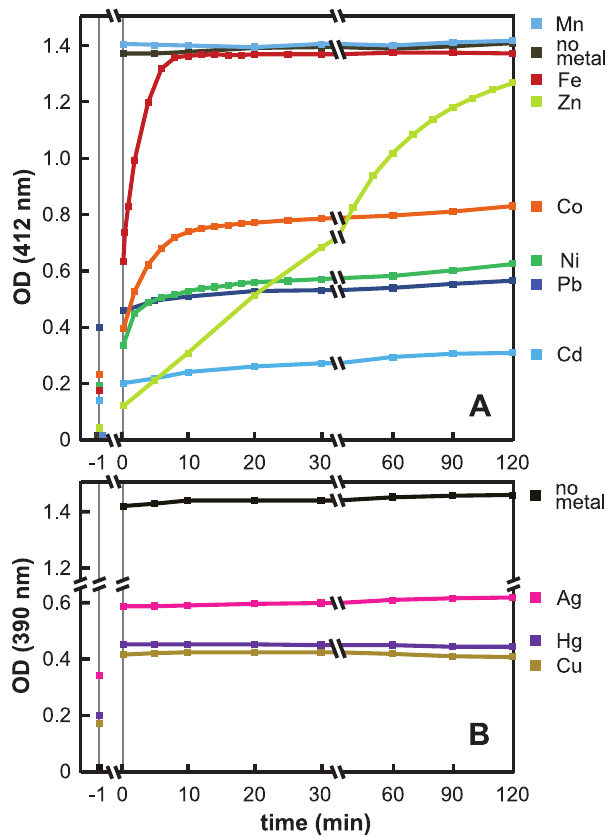
Figure 5. Reaction of metal-selenide colloids with DTNB. Mixtures containing 50 m M sodium selenide and 100 m M of the metal ion under study were prepared in an anaerobic glove box and left to incubate in this box for 10 min at room temperature (180 min in the case of Fe 2 + ). At time zero, 100 m M DTNB was added to the samples in the glove box. ( A ) Data with Co 2 + , Cd 2 + , Fe 2 + , Mn 2 + , Ni 2 + , Pb 2 + and Zn 2 + ions. TNB absorbance was followed at 412 nm. Data with Ca 2 + or Mg 2 + , which are similar to those with Mn 2 + or without metal, are not displayed in the figure. ( B ) Data with Ag + , Cu 2 + and Hg 2 + ions. TNB absorbance was followed at 390 nm instead of 412 nm (see Materials and Methods). In all cases, turbidities of the metal-selenide mixtures were measured in the glove box before DTNB addition. Corresponding values are indicated on the left side of the figure. Next, turbidities were measured just after DTNB addition. Because DTNB slightly absorbs light at 390 and 412 nm, values measured immediately after DTNB addition (0.25 min on the figure) systematically exceeded the values before DTNB addition ( 2 1 min on the figure). With Ag + , Cd 2 + , Cu 2 + , Hg 2 + , Pb 2 + and Zn 2 + , the OD increments upon DTNB addition (0.065 6 0.005 and 0.24 6 0.01 at 412 and 390 nm, respectively) were close to those obtained in a control experiment without metal and selenide (0.060 and 0.24 at 412 and 390 nm, respectively). With Co 2 + and Ni 2 + , the increments at 412 nm were slightly higher (0.14 and 0.16, respectively). With Fe 2 + , the increment was far higher (0.45 at 412 nm, see Results). of mercury(II) and selenite produces HgSe nanoparticles which subsequently bind a plasma protein, selenoprotein P, to form (Hg- Se) n -selenoprotein P complexes [41,42]. The fate of these